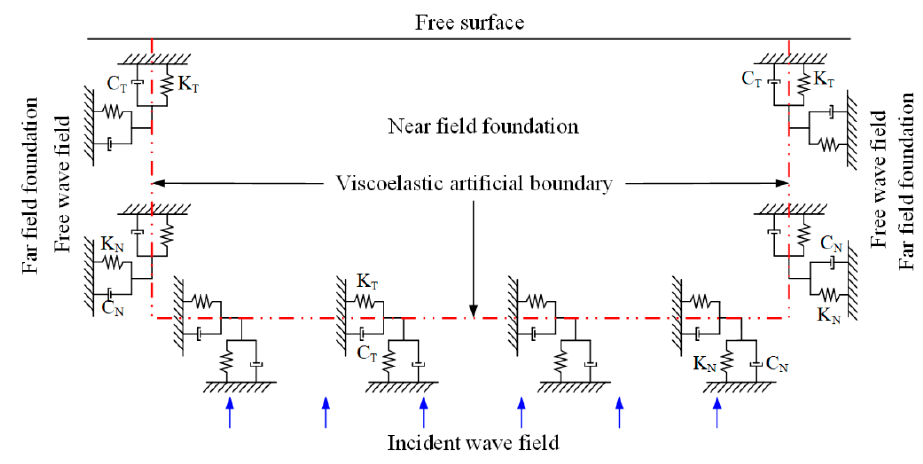
Figure 2. Schematic diagram of wave input for a viscoelastic artificial boundary. The displacement, velocity, and acceleration time history of wave fields are ex- pressed as ( ) i u t , ( ) i u t , and ( ) i u t , respectively, in which i m = denotes the total wave field, i r = denotes the incident wave field, i f = denotes the free wave field, and i s = denotes the scattered field. According to the displacement continuity condition and the mechanical equilibrium condition, the motion equation for node q on the bottom boundary can be expressed as: